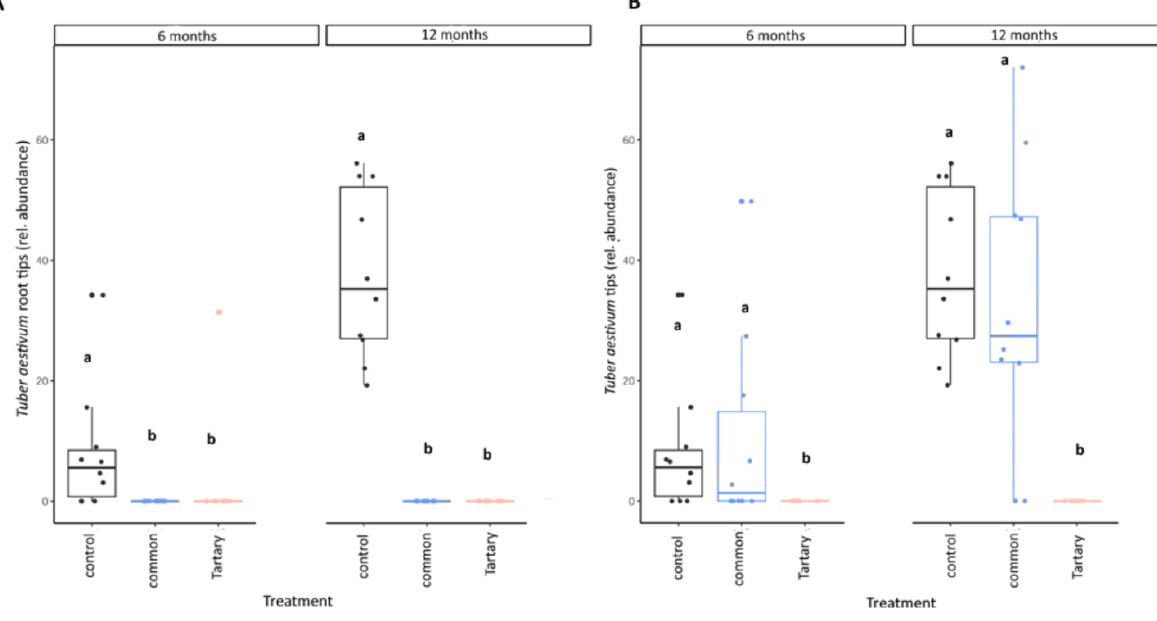
Figure 4. Summer truffle mycorrhization level at 6 months and 12 months after spore inoculation: ( A ) impact of added buckwheat husks; ( B ) impact of added buckwheat bran. Different letters mark statistically significant results (Kruskal–Wallis, p ≤ 0.05).